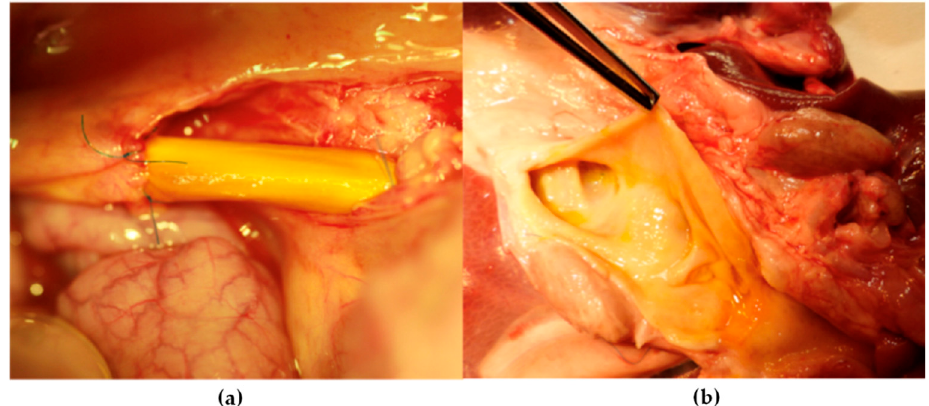
Figure 4. Photographs of implanted biocellulose tube V3 in pig studies. ( a ) Implantation of the biocellulose tube (end-end-anastomosis) after resection of approximately 3 cm common bile duct; ( b ) after twelve weeks, the bile duct was completely regenerated. Publication of this figure by courtesy of Prof. Falk Rauchfuß.